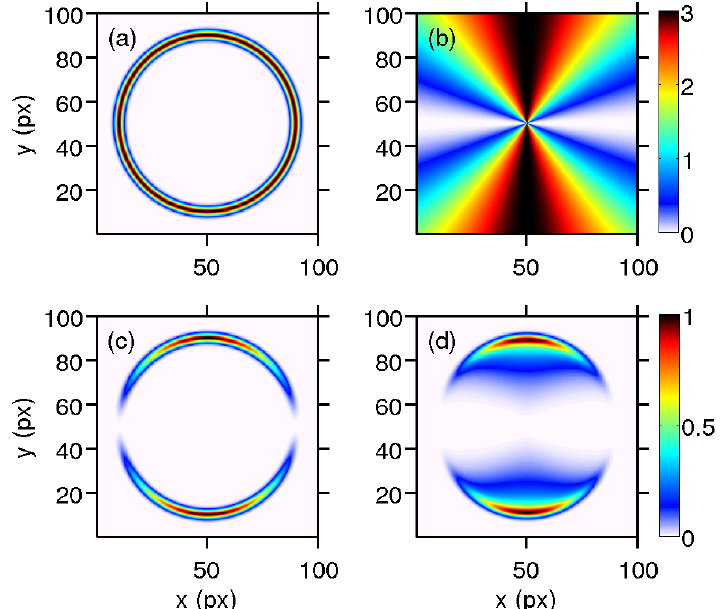
Figure 1. 2D representation of ( a ) the radial distribution given by Equation (1) with parameters r c = 40 px and σ c =3 px; ( b ) the angular distribution given by Equation (2) using β 2 = 2 and β 2 n > 2 = 0; ( c ) the product of the radial and angular distributions shown in ( a , b ), and ( d ) the corresponding Abel projection of ( c